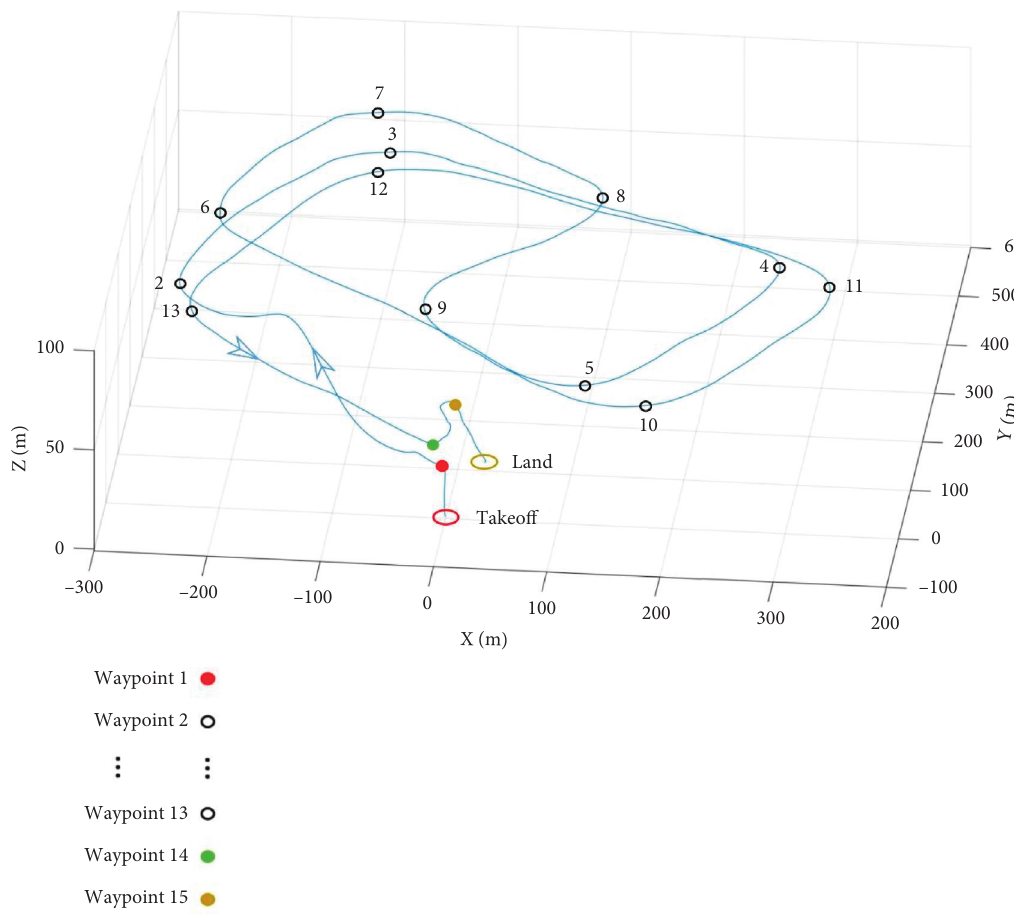
Figure 19: Flight trajectory of the aircraft in the flight experiment.